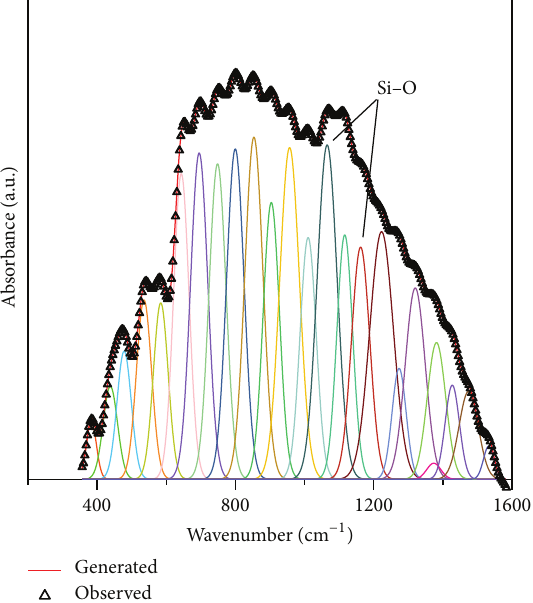
Figure 2: Raw (denoted as symbol) and deconvoluted (designated as lines) FTIR spectra of TiO 2 film, deposited on c-Si substrate. Figure 3: Current-voltage variation of Ag/TiO 2 /p-c-Si structure under dark/light condition in forward/reverse direction.